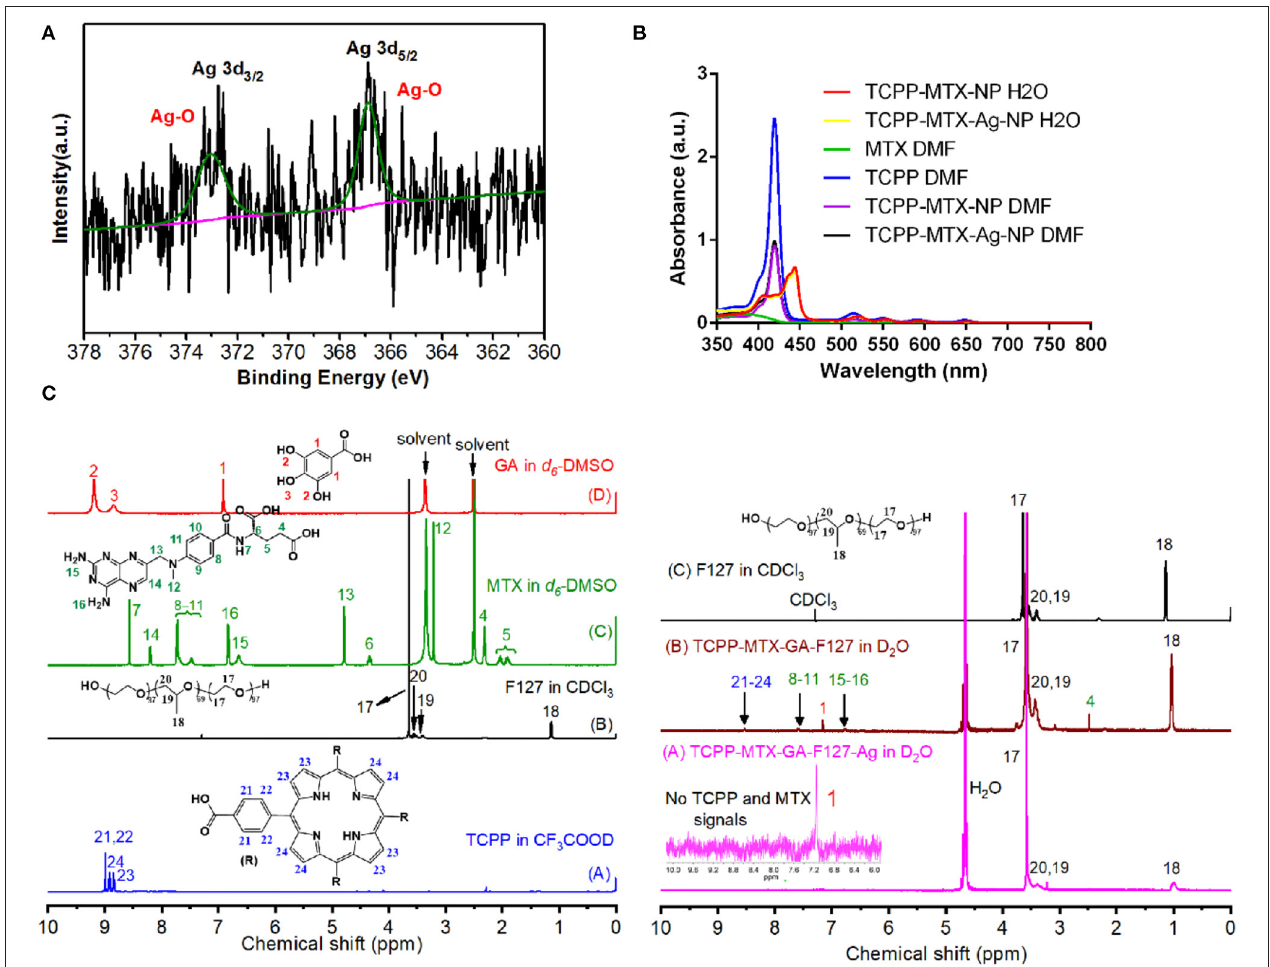
FIGURE 2 | The structure analysis of the TCPP-MTX-Ag-NP. (A) The XPS spectrum to show the presence and valance of silver element; (B,C) The UV spectrum and 1H-NMR spectrum of different components in the TCPP-MTX-Ag-NP.